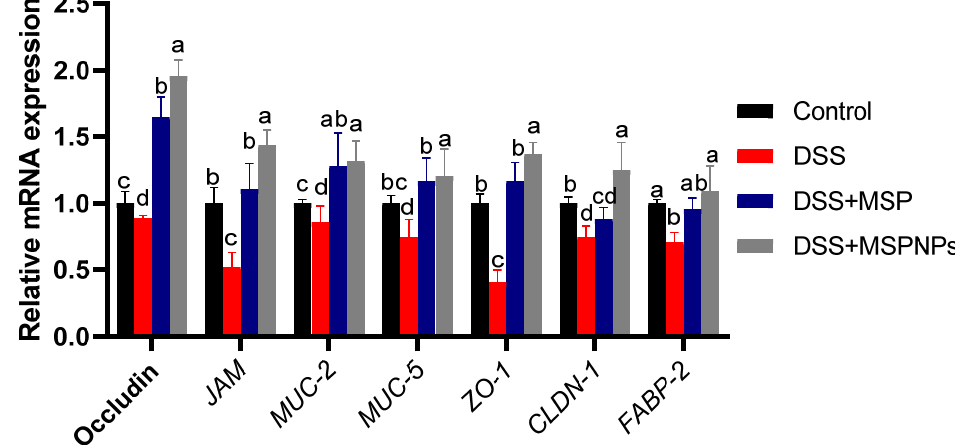
Figure 5. Effects of orally administered free multi-strain probiotics (MSPs) or multi-strain-probiotic- loaded nanoparticles (MSPNPs) on mRNA expressions of tight-junction-related genes (occludin, junction adhesion molecule (JAM), mucin-2 (MUC-2), mucin-5 (MUC-5), zonula occludens (ZO-1), claudins (CLDN-1) and fatty acid binding protein (FABP-2)) 14 days post DSS induction. Non-colitic group: Control (rats were orally gavaged with PBS). Colitic groups including: DSS (rats were orally gavaged with dextran sodium sulphate), DSS + MSPs (rats were orally gavaged with DSS and multi- strains probiotics (MSPs) at the level of 1.0 × 10 10 CFU/kg in 1 mL of PBS/rat/day for 14 days), DSS + MSPNPs (rats were orally gavaged with DSS and multi-strain-probiotic-loaded nanoparticles (MSPNPs) at the level of 1.0 × 10 10 CFU/kg in 1 mL of PBS/rat/day for 14 days); all groups were orally gavaged with 5% DSS. Values are expressed as mean ± SE. a,b,c,d Means of the bars with different letters were significantly different among groups ( p <